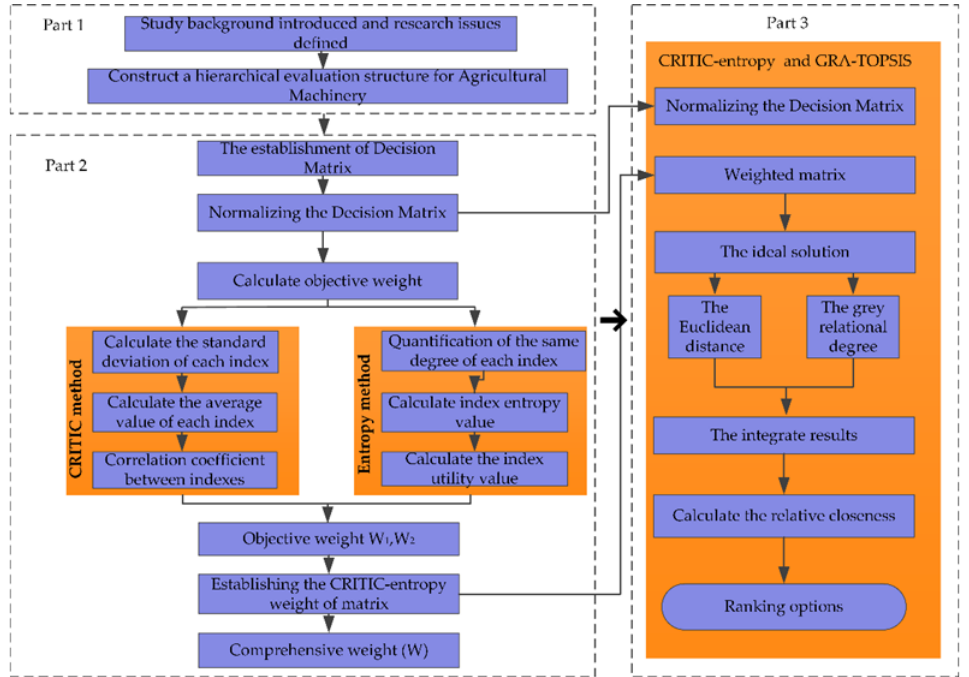
Figure 2. Research framework .